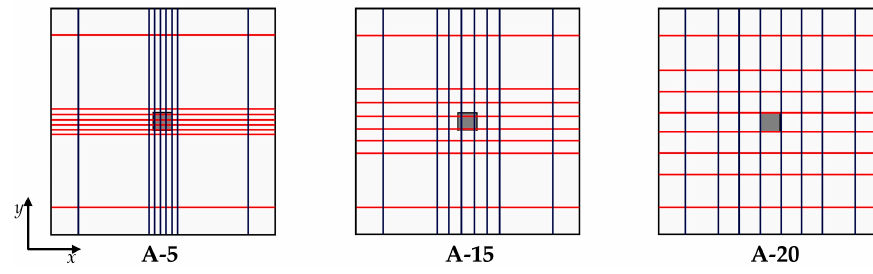
Figure 12. Plan view of the Series A prestressing tendons.